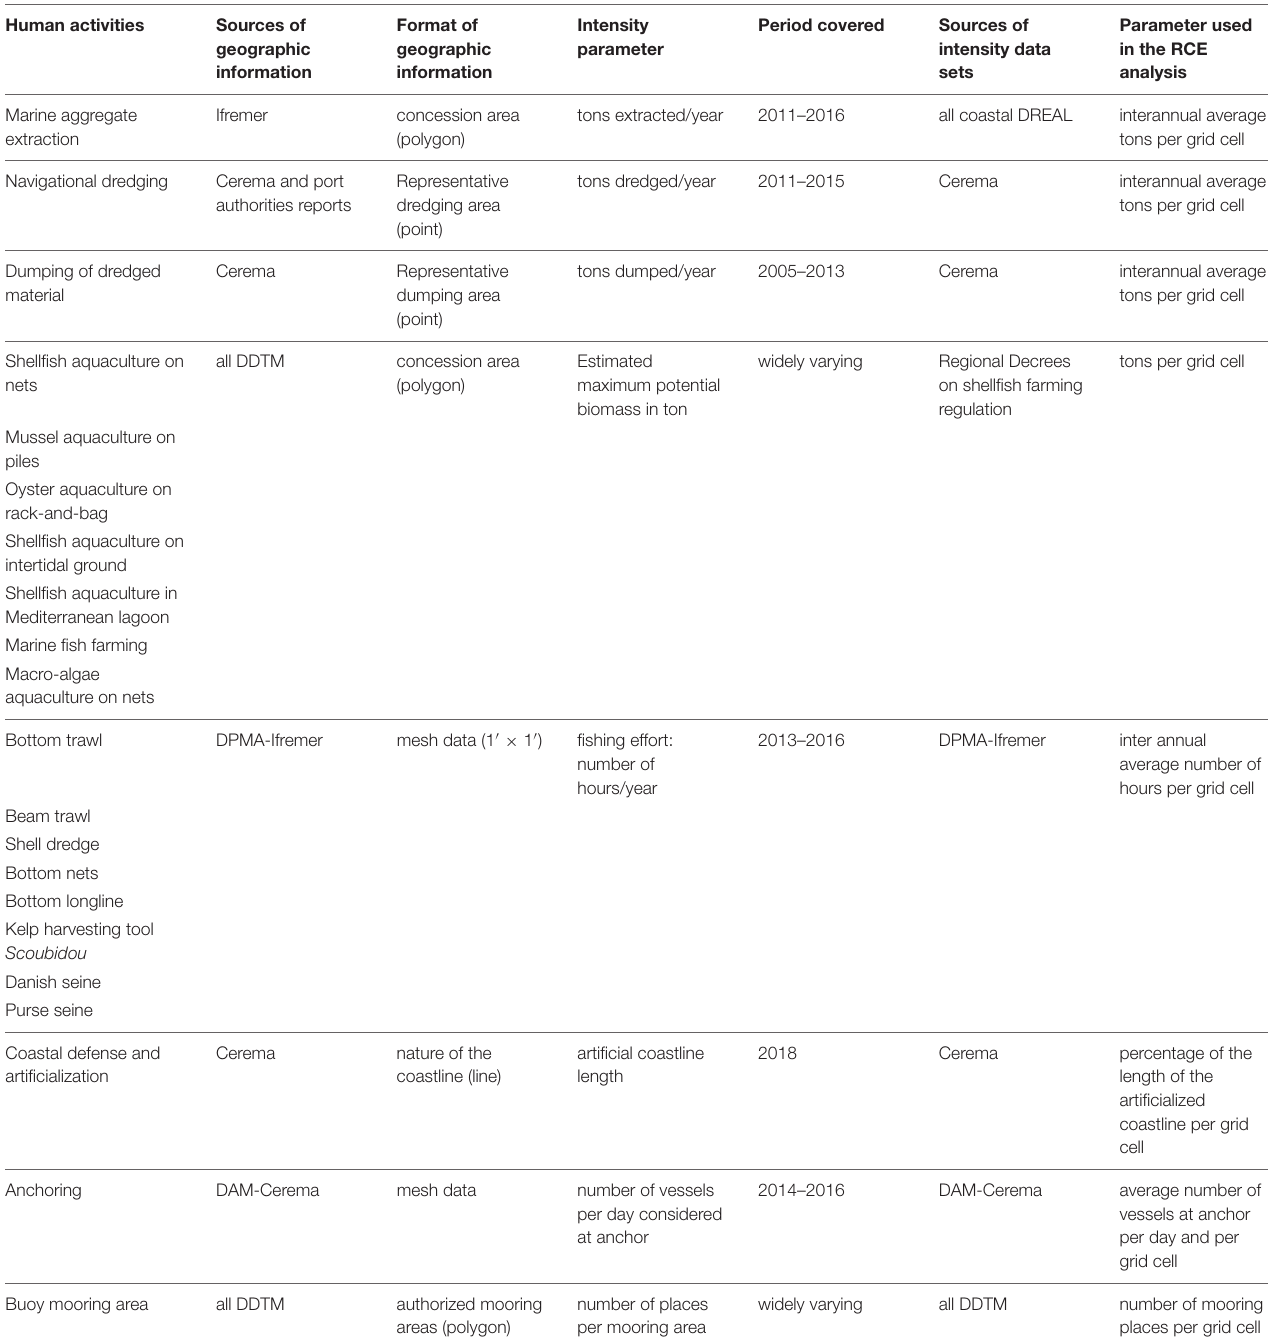
TABLE 4 | Description of human activities data sets